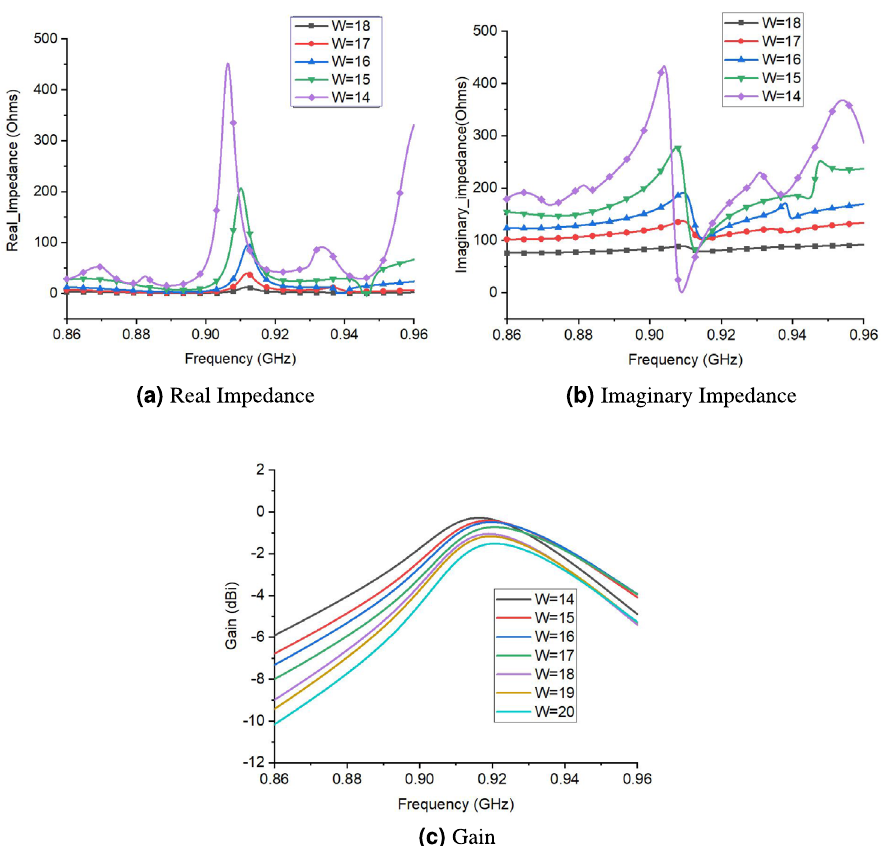
Figure 8. Performance of proposed tag design for different values of W (width of